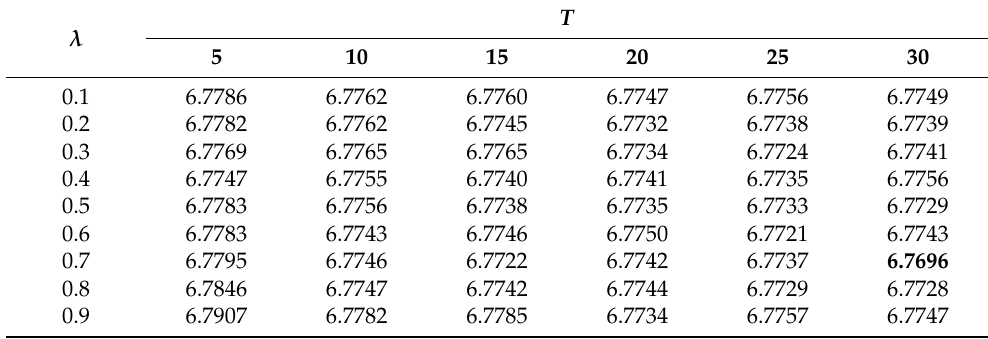
Table 4. Performance of proposed SAE-ELM model with different values of λ and T .